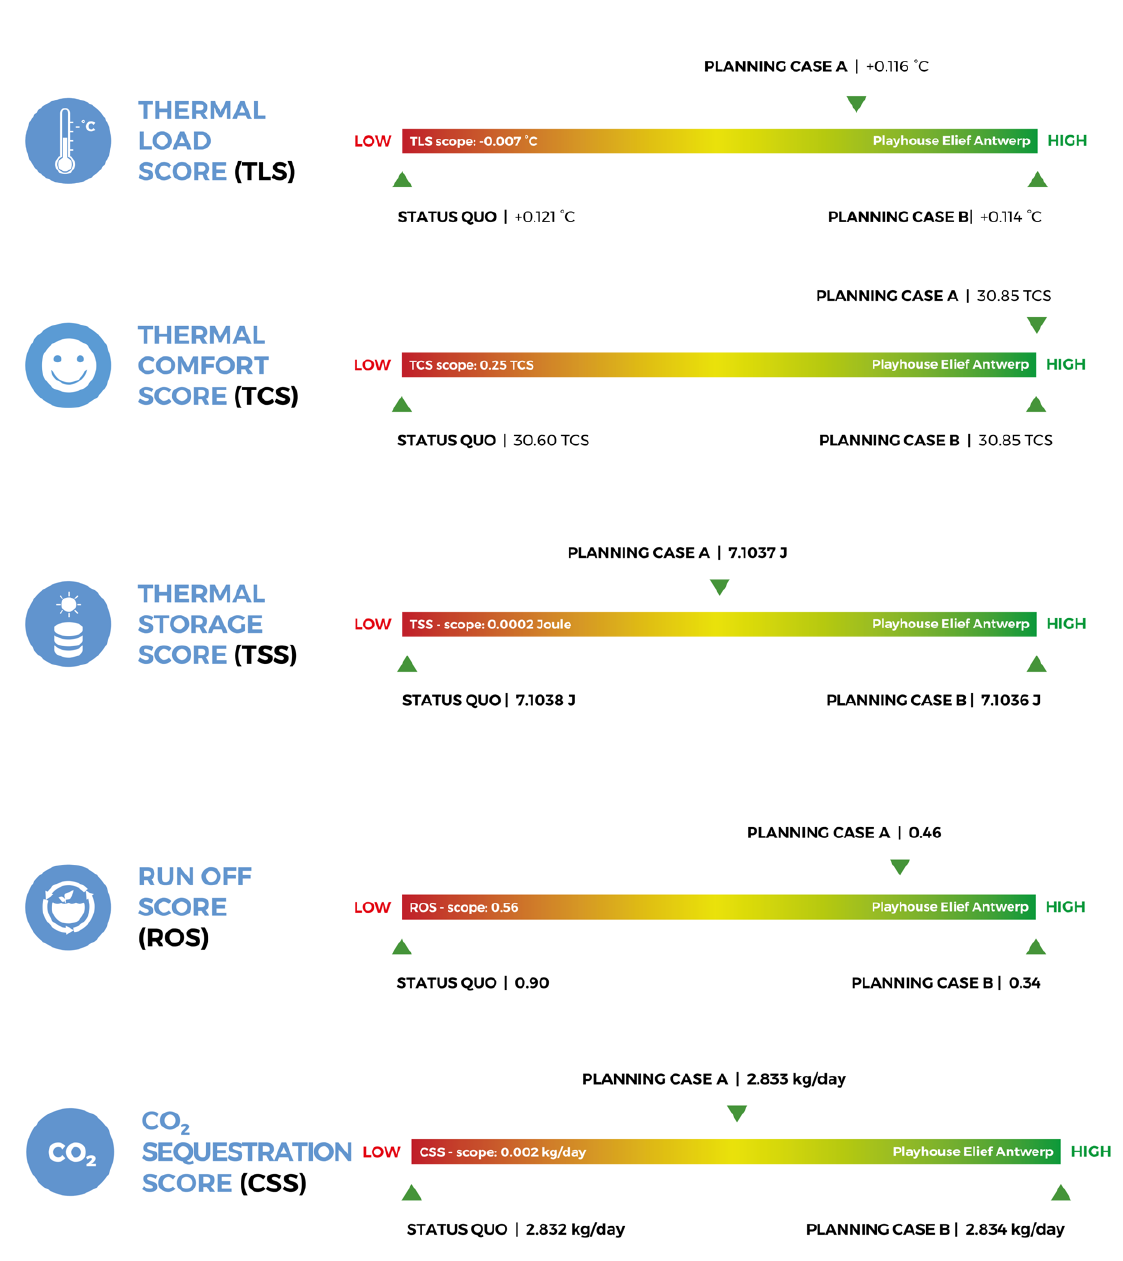
Figure 13. GREENPASS key performance scores (KPS)—Playhouse Elief Antwerp, three design variants (SQ, A, B).